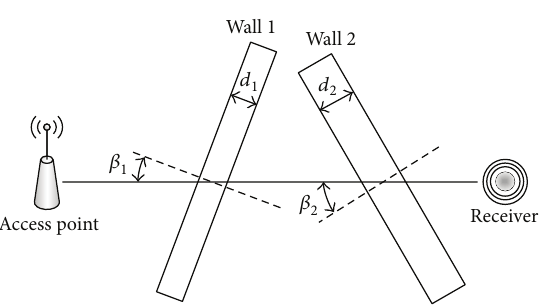
Figure 3: WiFi signal attenuation through